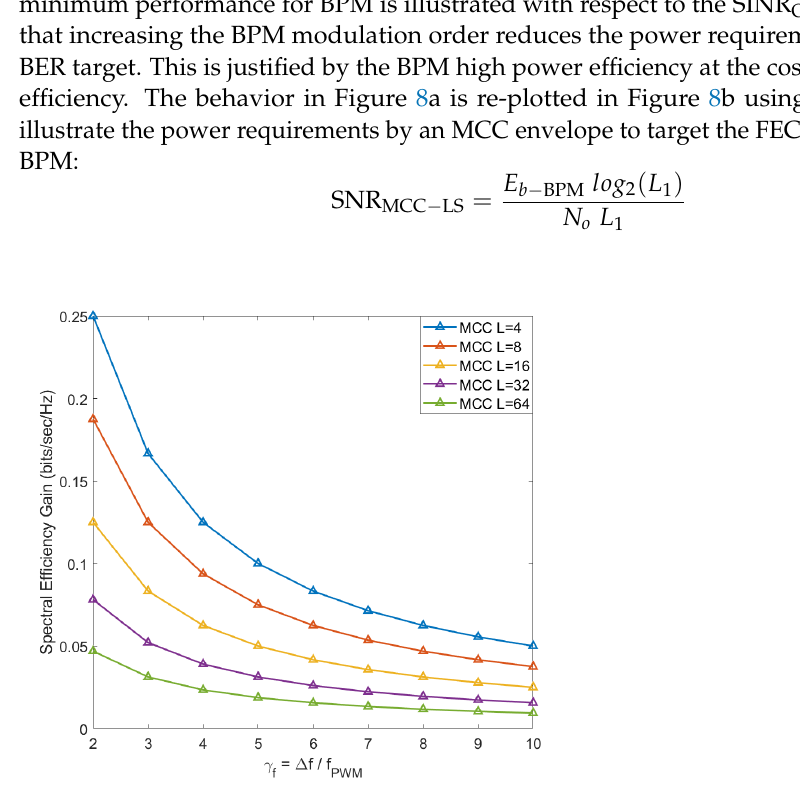
Figure 7. Spectral efficiency gain of MCC-LS with respect to γ f